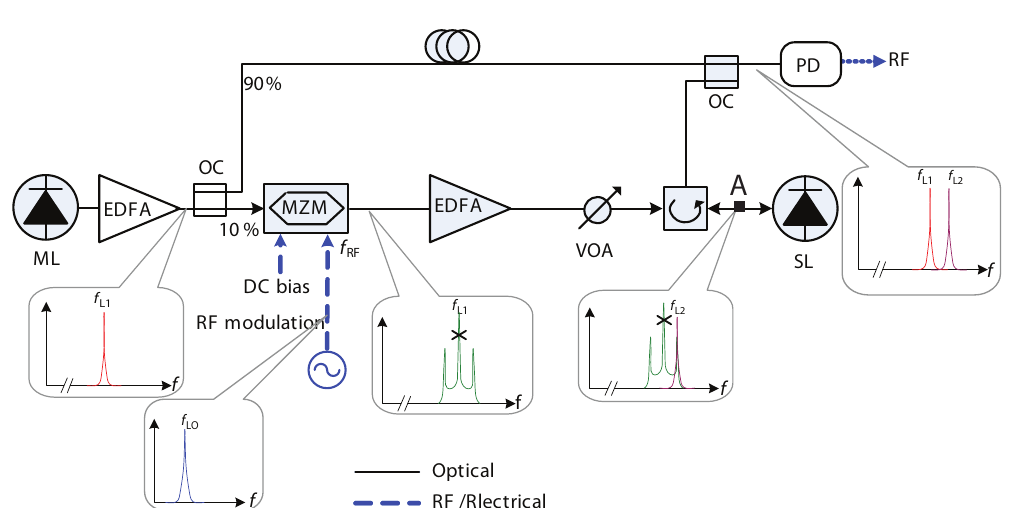
Figure 4. Schematic of the experimental setup for injection locking of WECSLs. Highlights point out the spectra at various points. ML, master laser; OC, optical coupler; MZM, Mach–Zehnder modulator; EDFA, erbium doper fiber amplifier; VOA, variable optical attenuator; SL, slave laser; PD, photo-detector. The optical power from the master laser is injected into the slave laser at Point